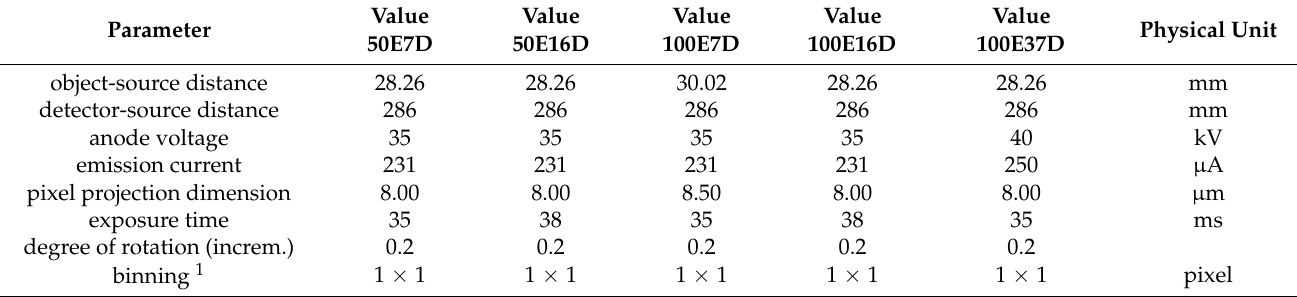
Table A12. Values of set parameters on SkyScan 1275 for scanning of the 11 kidneys samples.